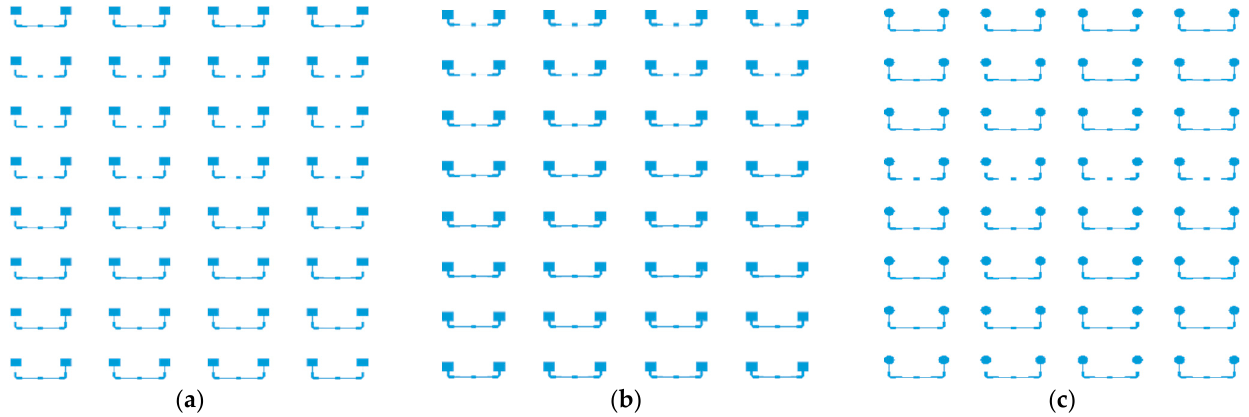
Figure 9. These arrays were the largest ones that were simulated in each case: ( a ) 1 × 2 array of 32 square patch elements with coupling length λ /4; ( b ) 1 × 2 array of 32 square patch elements with inset feed; ( c ) 1 × 2 array of 32 circular patch elements with coupling length λ /4. The horizontal and vertical spacing between the array elements is λ (a wavelength unit), and, as previously stated, arrays of 1, 2, 4, 6, 8, 12, 16, and 32 elements were simulated to observe the evolution of the different parameters with the increase in elements. Figure 10 depicts the behavior of return loss vs. frequency for each 16-element array, which present minimum values in the 60 GHz frequency. It can be noted that Antenna I (square patch with quarter-wave coupling) has a − 23.8 dB value, Antenna II (square patch with inset feed) has − 21.72 dB, and Antenna III (circular patch with quarter-wave coupling length) has − 39.64 dB.